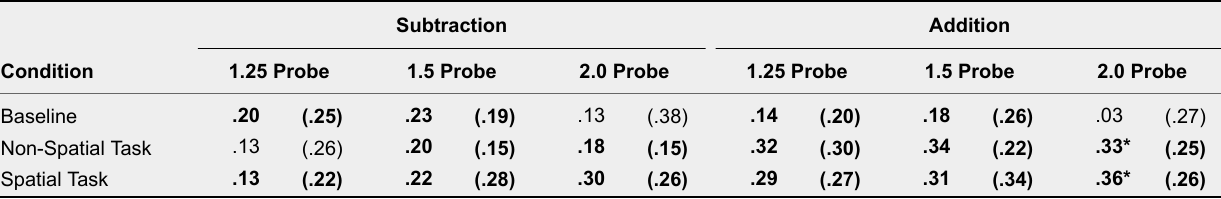
Operational Momentum Values as a Function of Probe Distance, Operation, and Experimental Condition Subtraction Addition Condition 1.25 Probe 1.5 Probe 2.0 Probe Baseline Non-Spatial Task Spatial Task